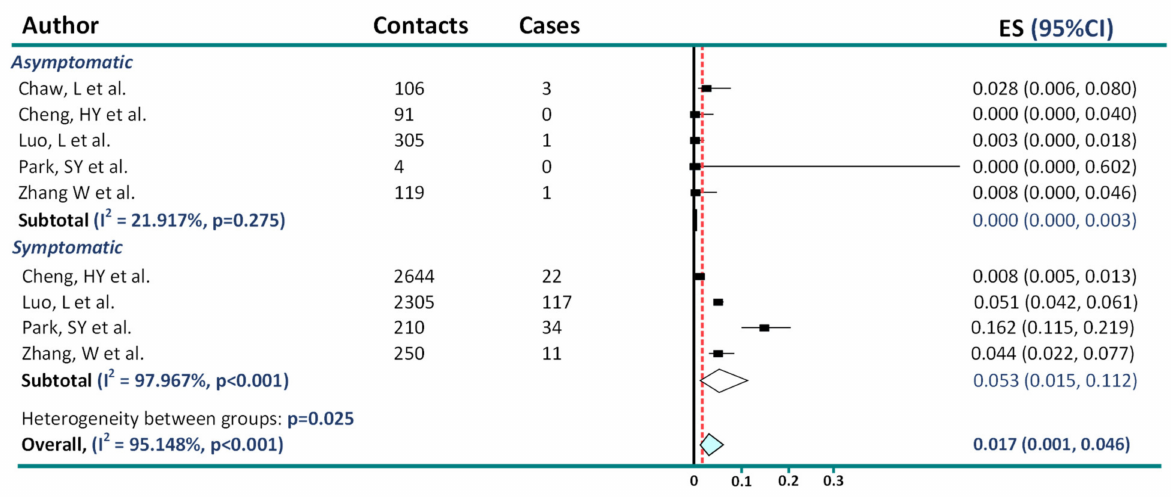
Figure 2. Reanalysis of data on asymptomatic and presymptomatic transmission adding Chaw et al. results [6–8,11,12].